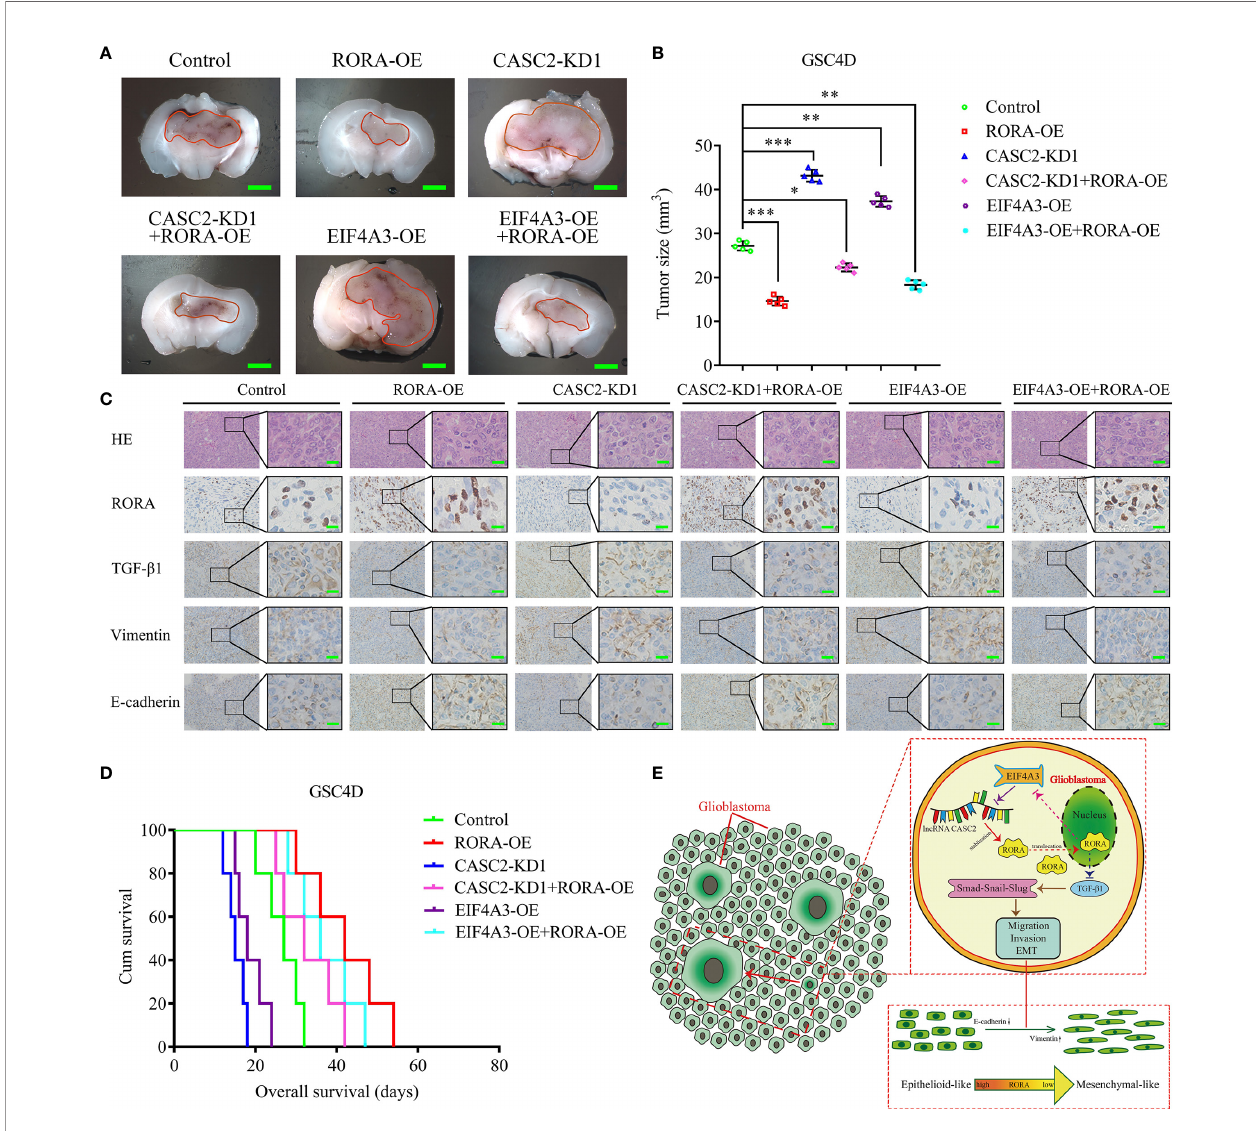
FIGURE 7 | The EIF4A3/CASC2/RORA axis regulates GBM tumorigenesis in vivo . (A) Representative image shows the size of intracranial tumors in the coronal location of six groups (negative control, RORA overexpression, CASC2 knockdown, CASC2 knockdown combined with RORA overexpression, EIF4A3 overexpression, and EIF4A3 overexpression combined with RORA overexpression in GSC4D). Scale bar = 10 mm. (B) The measured tumor volumes among six groups are indicated. (C) Representative immunohistochemical staining showing the changes in RORA, TGF- b 1, vimentin, and E-cadherin in the negative control, RORA overexpression, CASC2 knockdown, CASC2 knockdown combined with RORA overexpression, EIF4A3 overexpression, and EIF4A3 overexpression combined with RORA overexpression in orthotopic xenograft models. Scale bar = 50 m m. (D) Kaplan-Meier survival curves show that the CASC2 knockdown and EIF4A3 overexpression in GSC4D shortened the survival times of nude mice, while it prolonged the survival times after RORA overexpression, CASC2 knockdown combined with RORA overexpression, and EIF4A3 overexpression combined with RORA overexpression. For each group, n = 5. (E) Schematic diagram showing that the EIF4A3/CASC2/ RORA axis regulated the migration, invasion, and EMT of GBMs through the TGF- b 1/Smad signaling pathway. EV, empty vector; OE, overexpression; NC, negative control; KD, knockdown. All data are expressed as the mean ± SD (three independent experiments). *P < 0.05; **P < 0.01; ***P <